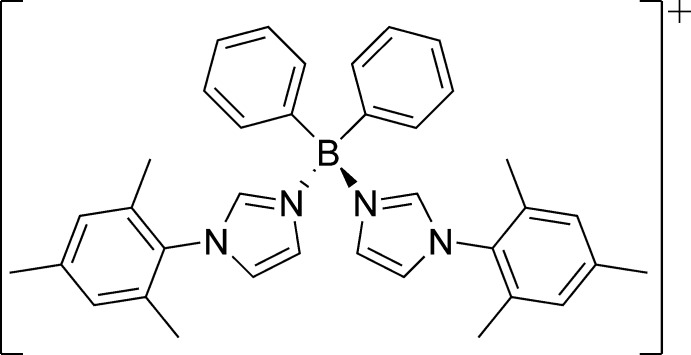
Chemical structure of di­phenyldi(mesityl­imidazole)­borane Ph2B(MesIm)2+.